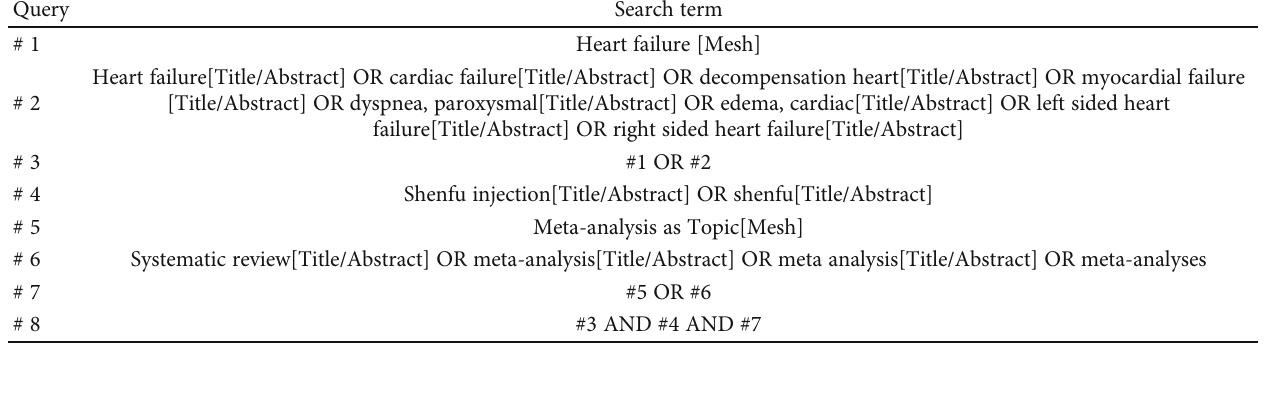
Table 1: Search strategy for the PubMed database.